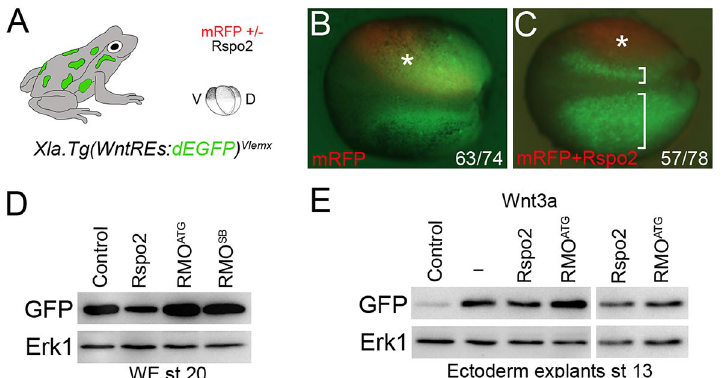
Figure 3. The effects of Rspo2 manipulation on Wnt reporter activity in transgenic embryos. ( A ) Experimental scheme. Xla.Tg(WntREs:dEGFP) Vlemx embryos were injected into one dorsal blastomere with mRFP RNA (50 pg) with ( C ) or without ( B ) Rspo2 RNA (0.5 ng). GFP fluorescence of the injected embryos at stage 18 is shown. Embryo images are representative of 3 different experiments. Asterisk indicates the injected side of the embryo, brackets in C show the comparison of the injected and the control sides. ( D , E ) Rspo2 modulates Wnt reporter activation. ( D ) Rspo2 RNA (0.5 ng), RMO ATG (10 ng) or RMO SB (20 ng) were injected at two dorsal blastomeres at 4-cell stage. The embryos were lysed at stage 20 and immunoblotted with anti-GFP antibodies. ( E ) Four-cell stage embryos were injected animally with Wnt3a RNA (50 pg) and Rspo2 RNAs (0.5 ng) or RMO ATG (10 ng). Ectoderm explants were dissected at stage 9 and cultured until stage 13, then lysed and immunoblotted with anti-GFP antibodies. Erk1 is a control for loading. In ( E ) two right lanes were run in the same gel but away from the left lanes (see Supplementary Fig. 5). Five embryos or 10 explants were pooled for each experimental condition in ( D , E